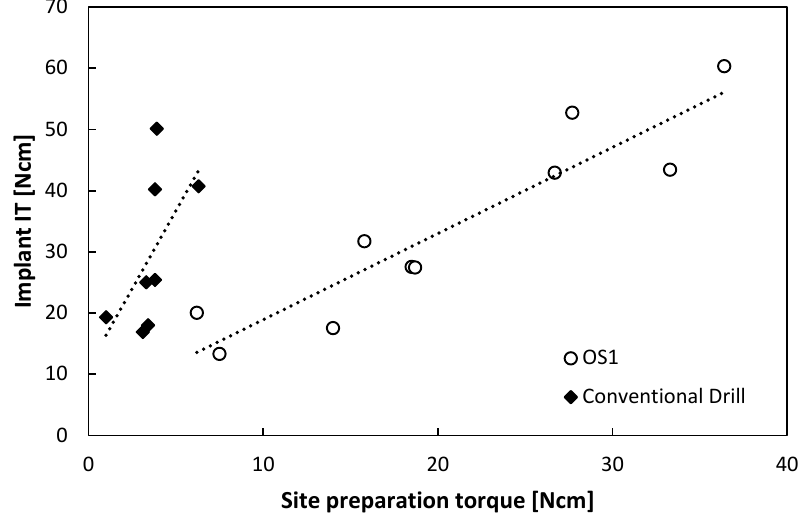
Figure 5. Linear regression of implant insertion torque versus OS1 insertion torque ( n = 10) and versus conventional drill torque ( n = 8) in bovine trabecular bone samples.